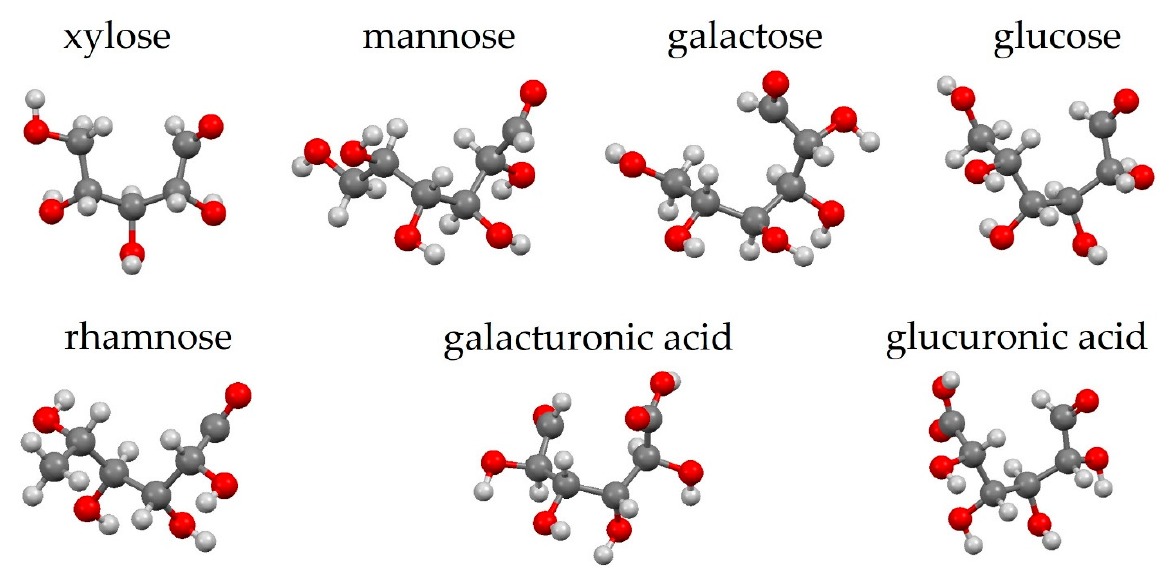
Figure 7. Scheme of mixtures of biomass ‐ derived hemicellulose carbohydrates used in the one ‐ pot